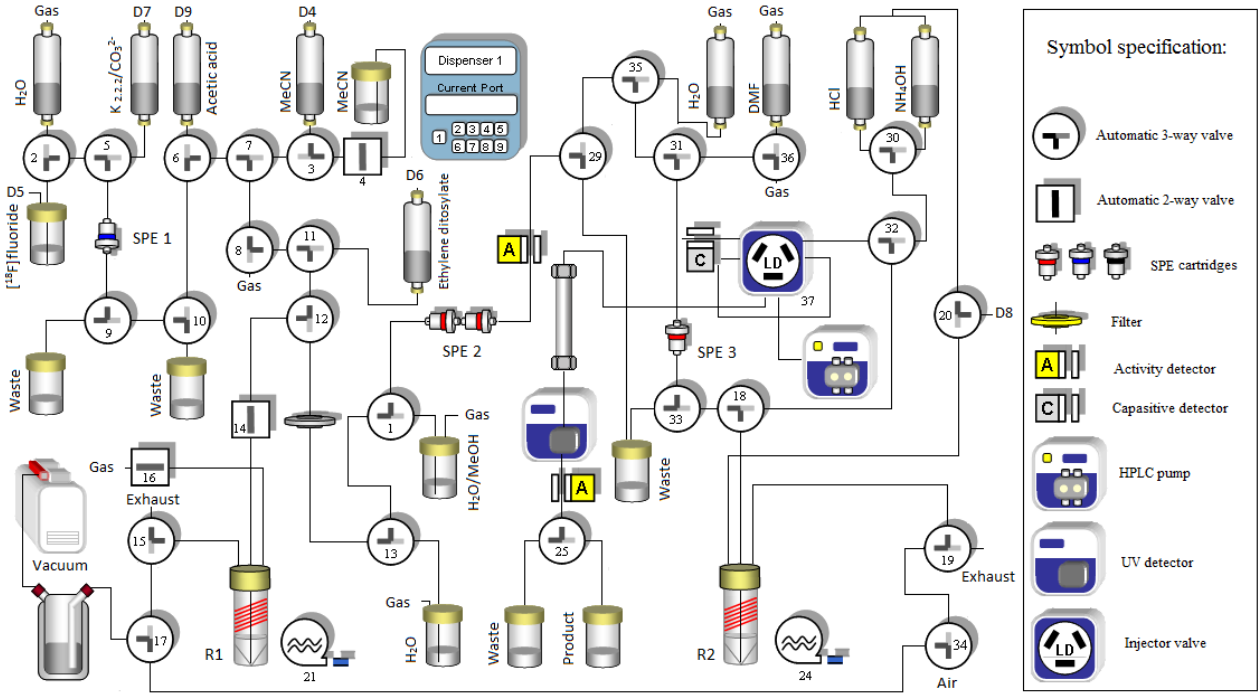
Figure 1. Schematic diagram showing the automated set up on a HB III module (Scintomics) for the two-pot, three-step radiosynthesis; from drying of [ 18 F]fluoride to HPLC separation of [ 18